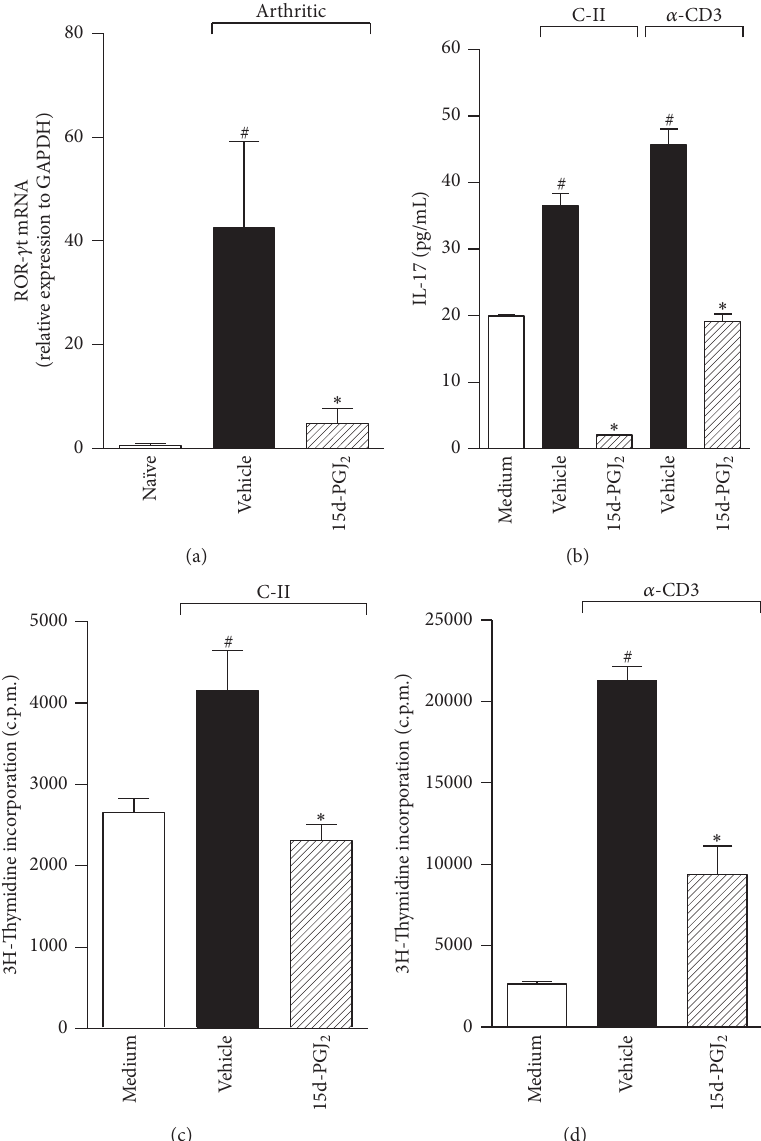
Figure 4: 15d-PGJ 2 suppresses the collagen-induced Th17 immune response. ROR- 𝛾 t mRNA expression was quantified by real-time PCR in draining lymph nodes from na¨ıve mice (white bar) or collagen-immunized and challenged DBA/1 mice treated with vehicle (PBS) (black bar) or–15d-PGJ 2 (1mg/Kg)(hatchedbar)for7days(a). # 𝑃 < 0.05 whencomparedwithna¨ıvemice. ∗ 𝑃 < 0.05 whencomparedwithvehicle(PBS). 15d-PGJ 2 -pretreated nonadherent cells (2 × 10 6 cells/mL) (1 hour before) from draining LNs from the mice above were stimulated in vitro with C-II (5 𝜇 g/mL) or plate-bound 𝛼 -CD3 (5 𝜇 g/mL) for 96 h. Culture supernatants were harvested to measure IL-17 (b) levels from C-II- or 𝛼 -CD3-stimulated cultures. The specific C-II (c) or 𝛼 CD3 polyclonal (d) stimuli proliferation assay was assessed by overnight [ 3 H]thymidine incorporation. The results are expressed as the mean ± SEM obtained from triplicate samples from two or three independent experiments ( N = 3 per group). # 𝑃 < 0.05 when compared with medium. ∗ 𝑃 < 0.05 compared with vehicle